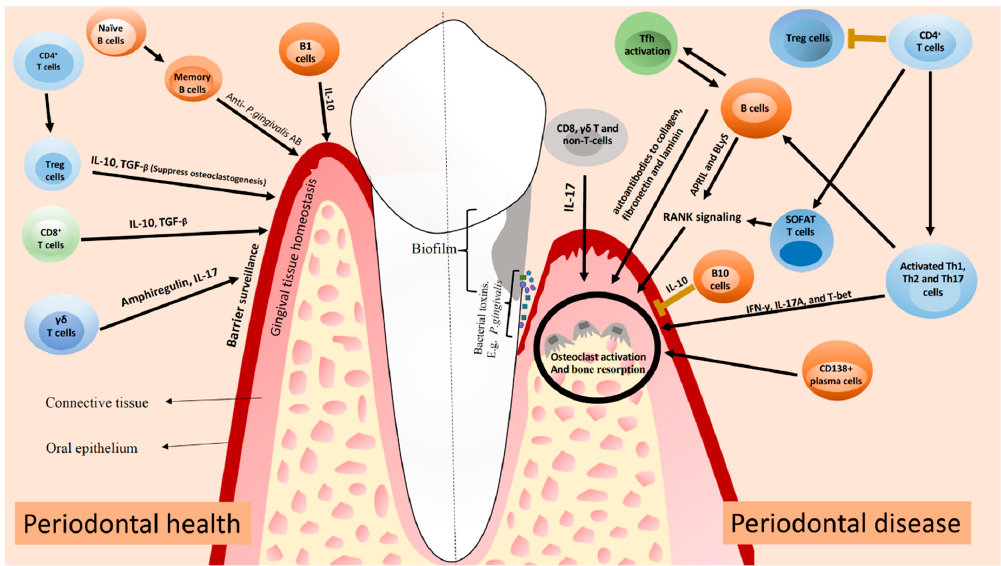
Figure 1. A summary of how mentioned T and B cells can contribute to periodontal health and disease. In periodontal health, Treg and CD8 + T cells contribute to periodontal homeostasis through the production of IL-10 and TGF- β . γδ T cells produce amphiregulin and IL-17 to promote periodontal homeostasis. B cells produce antibodies against periodontal pathogens, limiting the development of periodontal inflammation. In periodontal disease, activated Th1, Th2, and Th17 cells produce pro-inflammatory cytokines that contribute to tissue damage. Both T and B cells produce RANKL, which leads to osteoclast activation and alveolar bone resorption. Clonal activation of B cells by Tfh cells can lead to the production of autoantibodies to collagen, fibronectin and laminin, contributing to local tissue destruction. Lack of Treg cells or an impaired function probably impact on the development of periodontitis. IL-17 produced by other cells can also contribute to tissue damage via osteoclast activation. The figure was adapted from Lira-Junior & Figueredo